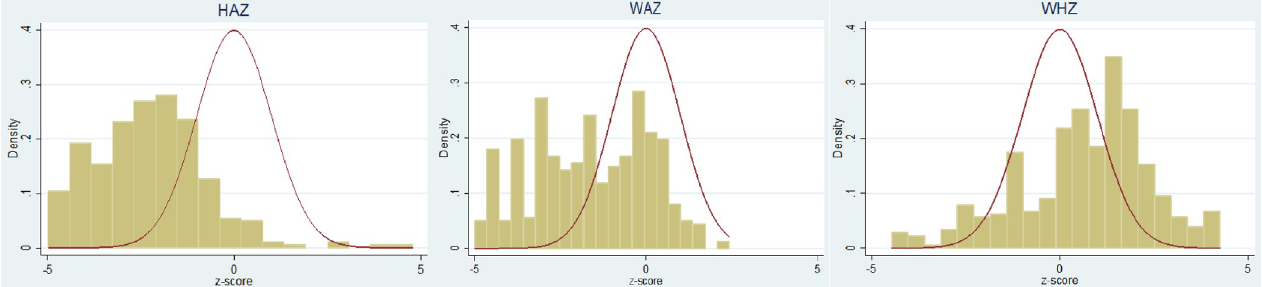
Fig 1. Distribution of z-scores in district Rahimyar Khan.